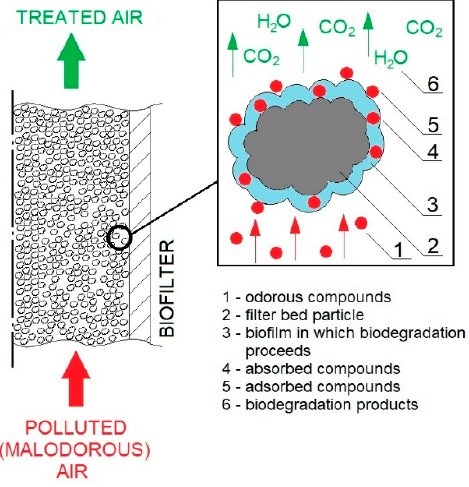
Figure 1. General mechanism of biofiltration.